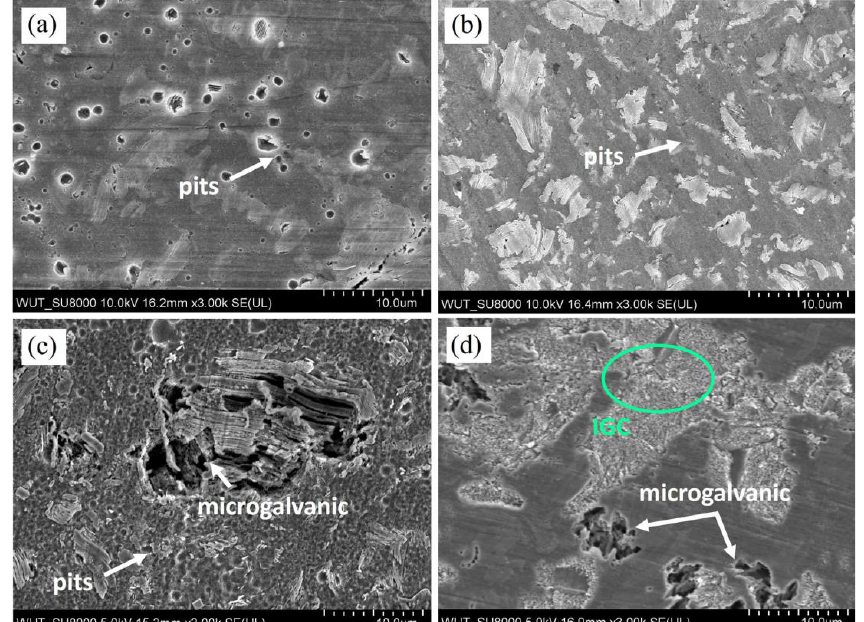
Figure 11. Characterization of the corroded surfaces of WZ104 after corrosion products removal after 1 h of immersion in naturally aerated ( a ) 0.01 M NaCl, ( b ) 0.1 M NaCl, ( c ) 1 M NaCl, and ( d ) PBS under aerated conditions.